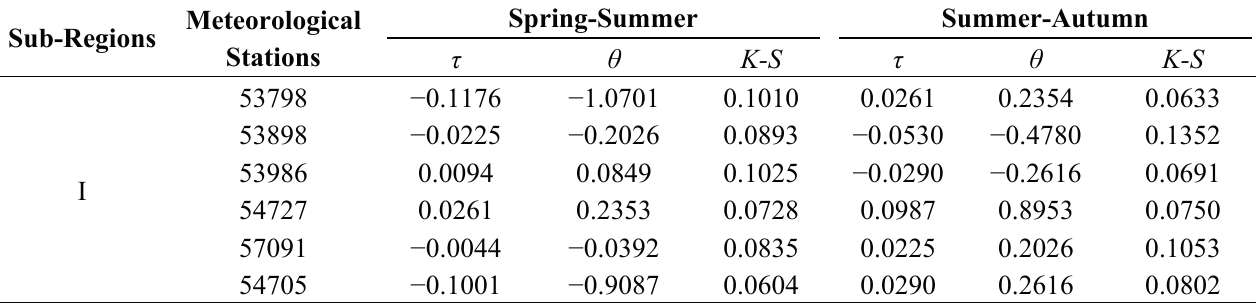
Table 8. Computation of Kendall rank correlation coefficient τ , parameter θ and K-S test in spring-summer and